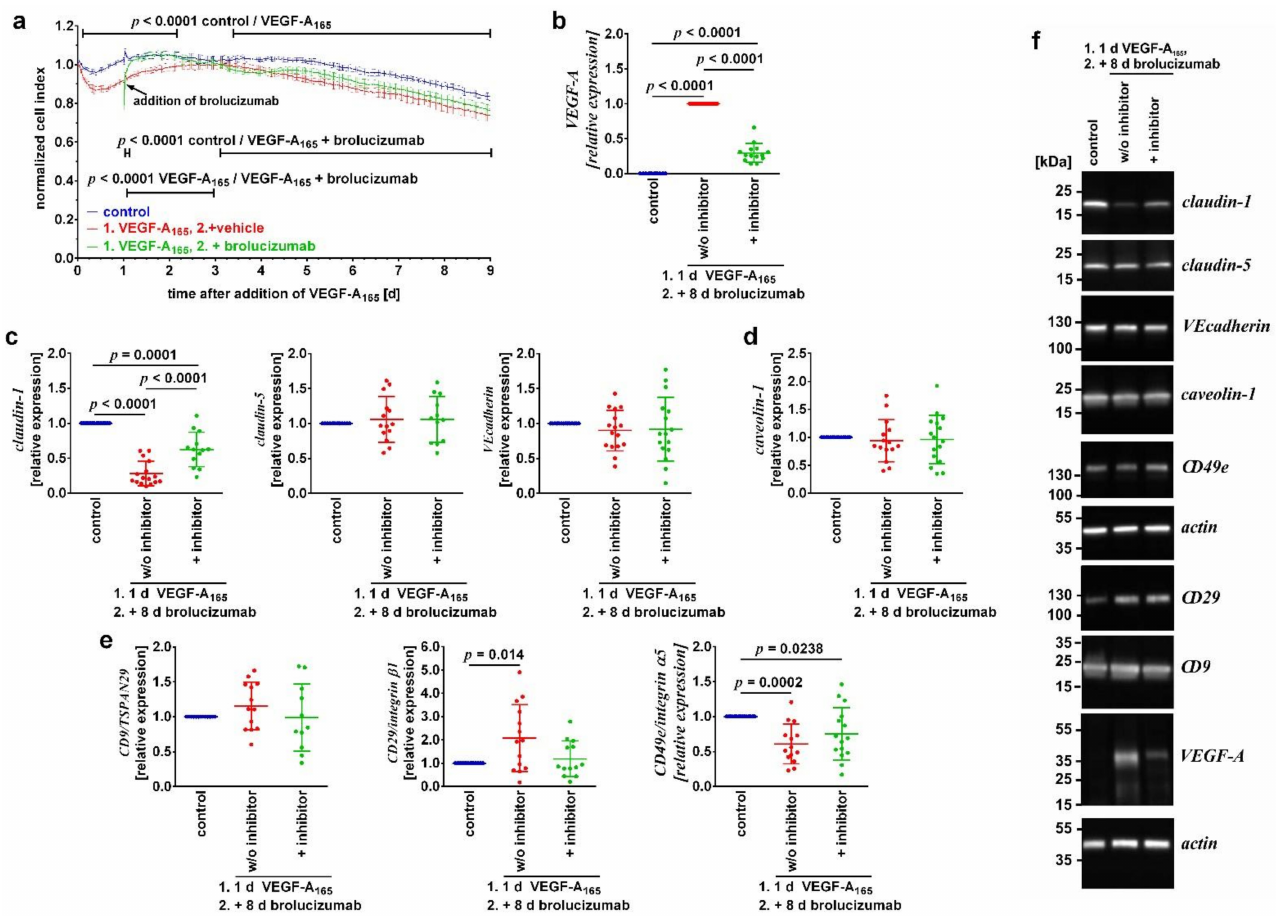
Figure 1. Prolonged treatment with VEGF-A 165 impaired the barrier formed by iBREC. Confluent monolayers of iBREC were exposed to VEGF-A 165 for nine days and ( a ) the cell index was measured continuously or ( b – f ) cells were harvested. Alternatively, iBREC were treated with the growth factor for one day, before the VEGF-A antagonist brolucizumab was added for an additional eight days. ( a ) VEGF-A 165 induced a persistent decrease in the cell index, which was quickly reverted by brolucizumab, but this effect was only stable for 1.5 days. Cell index values obtained from more than five wells per condition were normalized to those measured just before the addition of VEGF-A 165 and are shown as means ± standard deviations. Data were analyzed as described in “Materials and Methods”. ( b ) Less VEGF-A was taken up by iBREC in the presence of brolucizumab. ( c ) Levels of TJ-protein claudin-1 were low after exposure of the cells to the growth factor in the absence or presence of its antagonist. ( d ) None of the effectors changed expression levels of caveolin-1. ( e ) VEGF-A 165 induced higher levels of CD29/integrin α 1 but lower levels of CD49e/integrin α 5 not changed by brolucizumab. Signals obtained by Western blot analyses were normalized and statistical analyses performed as described in “Materials and Methods”. Pooled results of multiple Western blot experiments are shown as scatter plots also depicting means ± standard deviations where one dot represents the single signal obtained from one experiment. ( f ) Representative images of Western blot analyses; the original images are shown in Figure